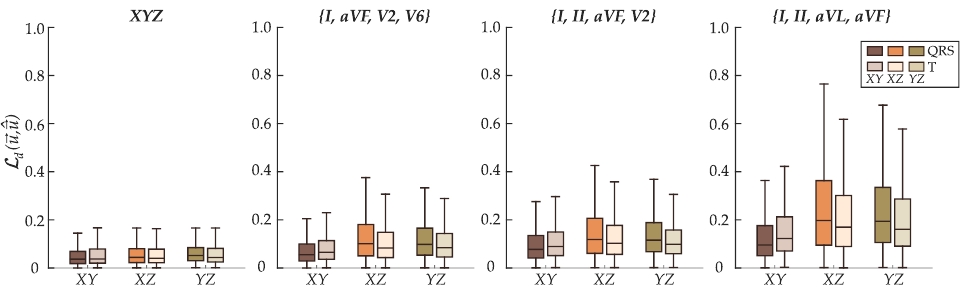
#» #» #» #» (cid:0) #» (cid:1) u , (cid:98) u u QRS and (cid:98) u QRS , and u T and between